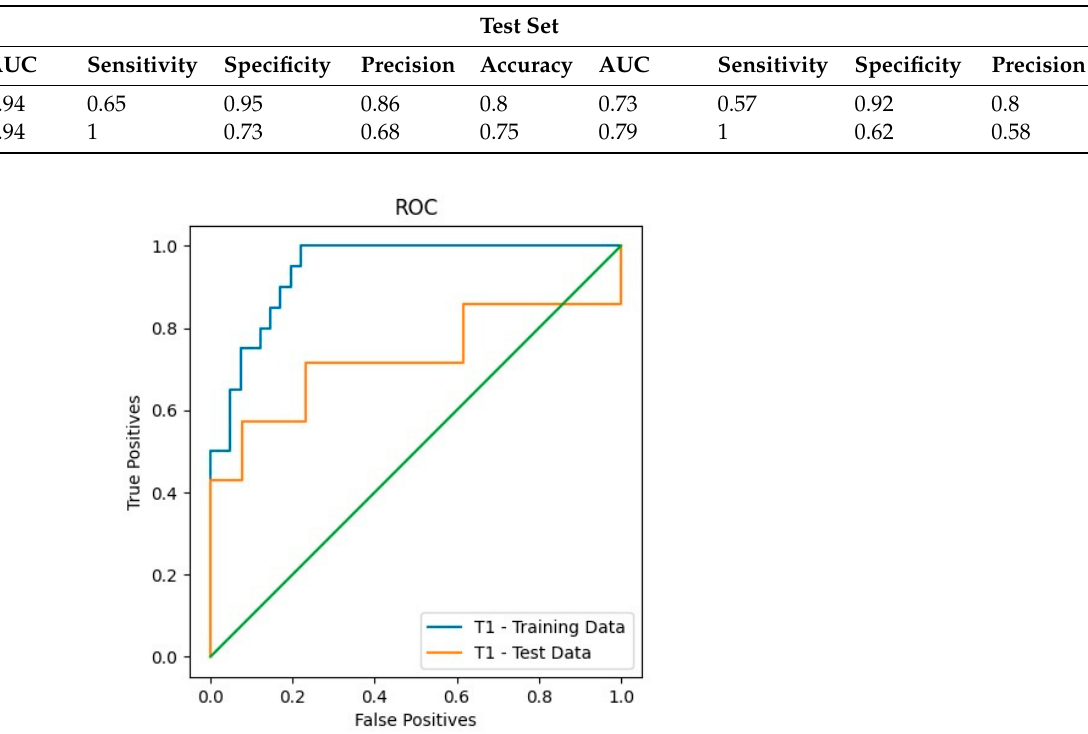
Figure 2. Receiver operating characteristic curve of the model using T1-weighted images as input.